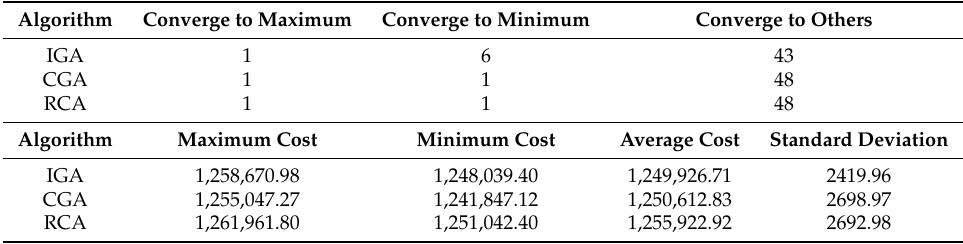
Figure 12. Average of total cost as a function of generations for IGA, CGA, and RCA on 1122 waiting jobs. Table 8. Convergence summary and statistical indicators for 50 MCS of IGA, CGA, and RCA on 1122 waiting jobs at iteration